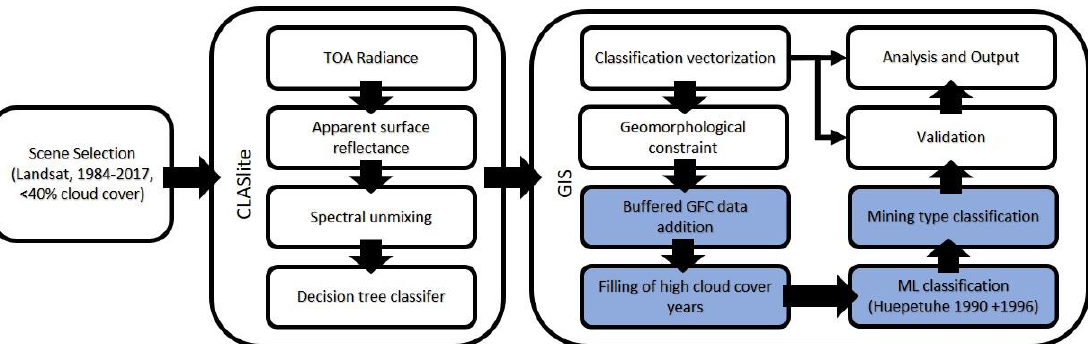
Figure 2. Workflow for fusion of CLASlite/GFC data and classification of ASGM. Cells highlighted in blue represent methodological advances.